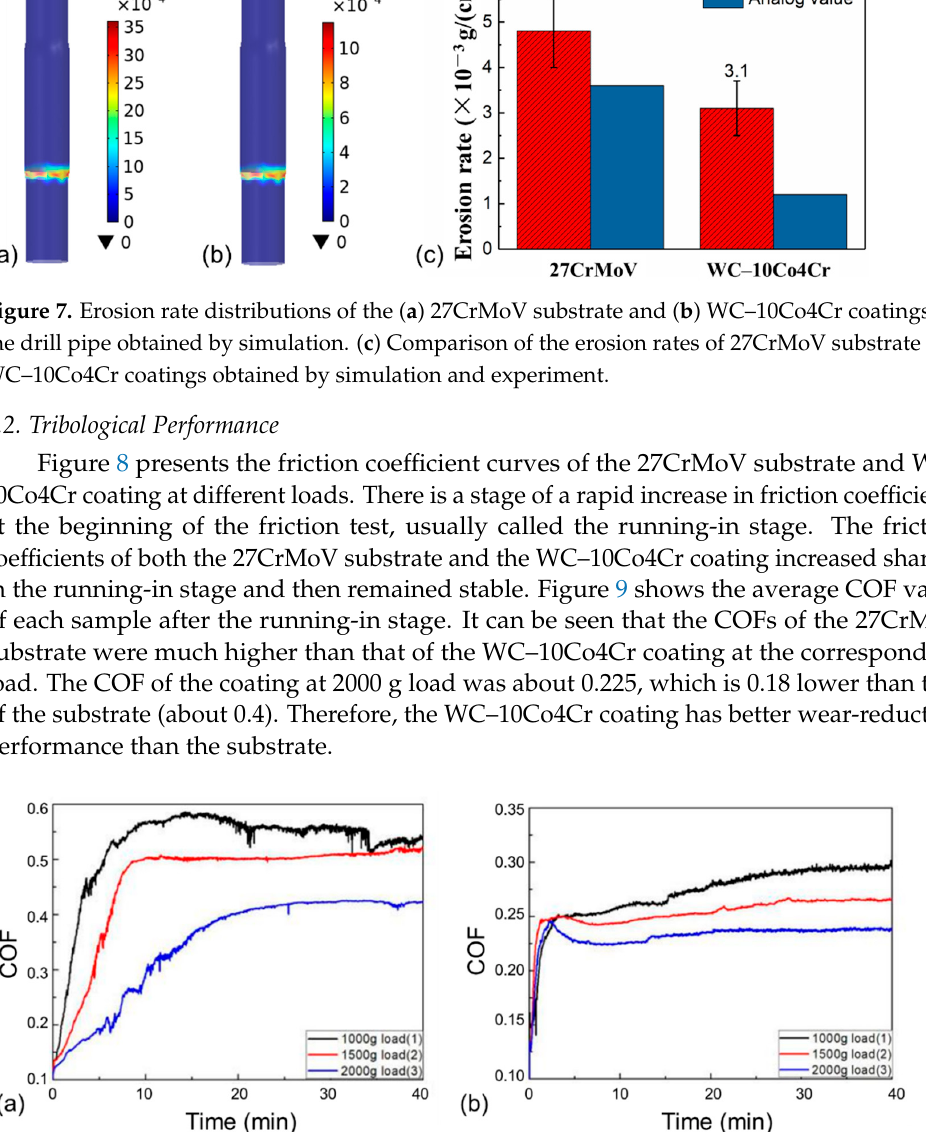
Figure 9. The average coefficient of friction after the running-in stage of the 27CrMoV substrate and WC–10Co4Cr coatings at different loads. Figure 10 shows the macroscale wear tracks on the 27CrMoV substrate and WC– 10Co4Cr coating at different loads. With the increase in the applied load, the wear of the samples gradually became significant. On the whole, the wear of the coating was less than that of the substrate. According to the statistics, the widths of the wear track on the 27CrMoV substrate at 1000, 1500, and 2000 g loads were 821, 1184, and 1495 μ m, respec- tively. The widths of the wear track on the WC–10Co4Cr coating at 1000, 1500, and 2000